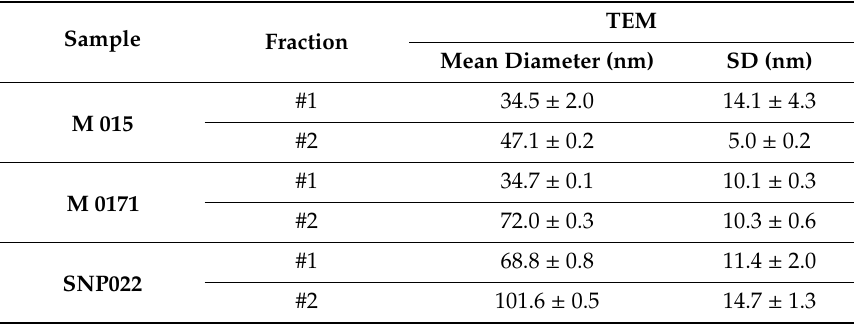
Table 1. Mean diameter and standard deviation (SD) values of the PSDs of each size fractions of the investigated bimodal SNPs obtained by TEM. Indicated standard error values were obtained from least-squares fitting of Gaussian